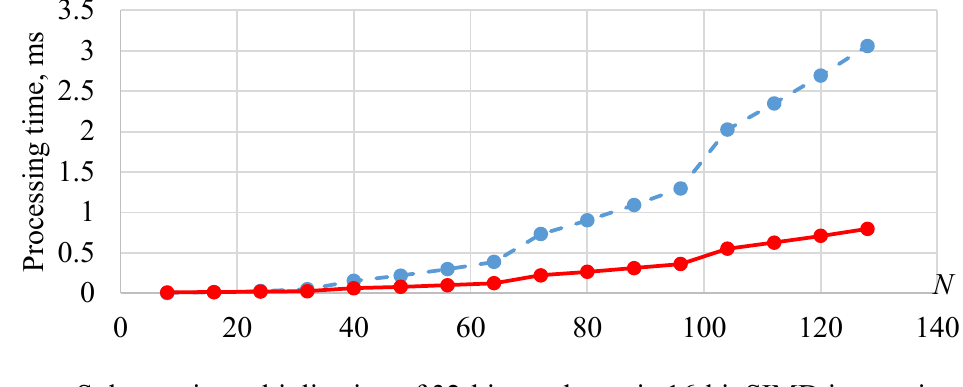
Figure 2. Processing time for matrix multiplication of 32-bit unsigned integers via decomposition on 16-bit vector registers in the scope of a sole matrix multiplication procedure and via four multiplications of 16-bit matrices.